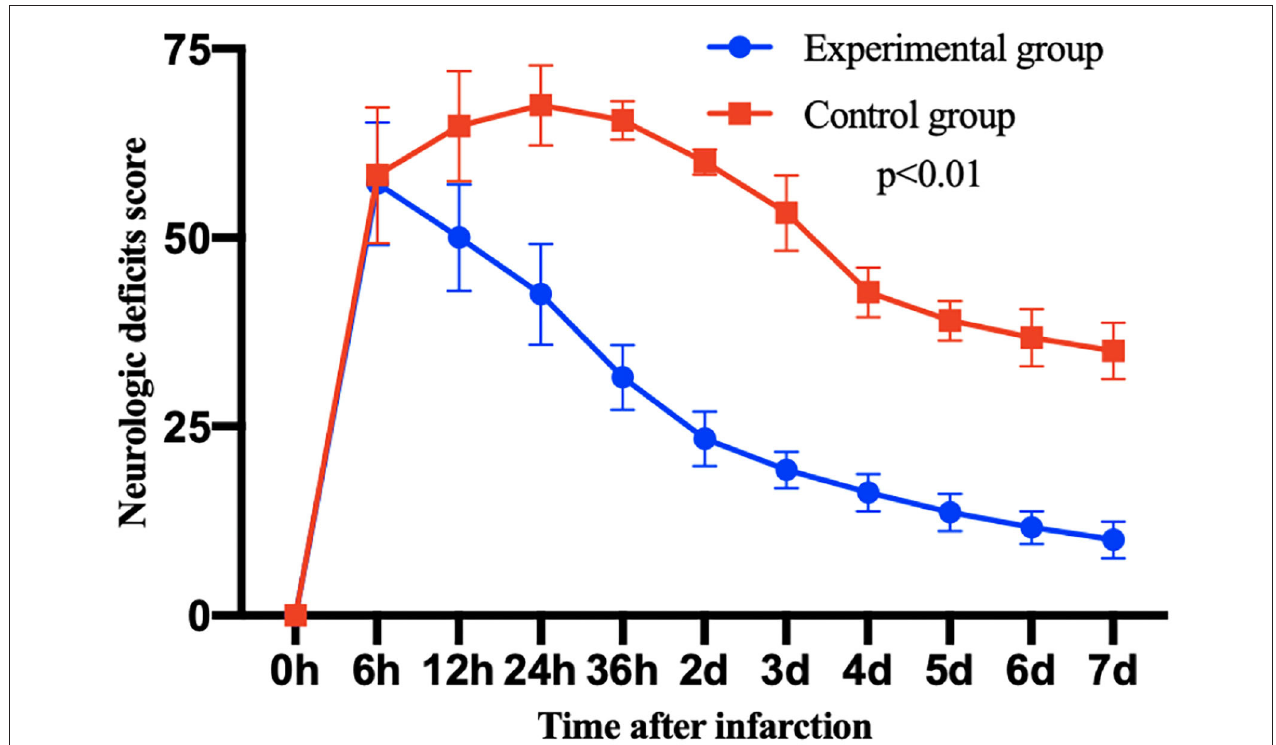
FIGURE 4 | The post-operative neurological deficit score of monkeys in each group after 7 days infarction. Then, 7 days after thrombolytic treatment, the scores of experimental group were significantly decreased compared with the control group. Data are mean ± SD. The y -axis represents neurological deficit score, the x -axis represents time after